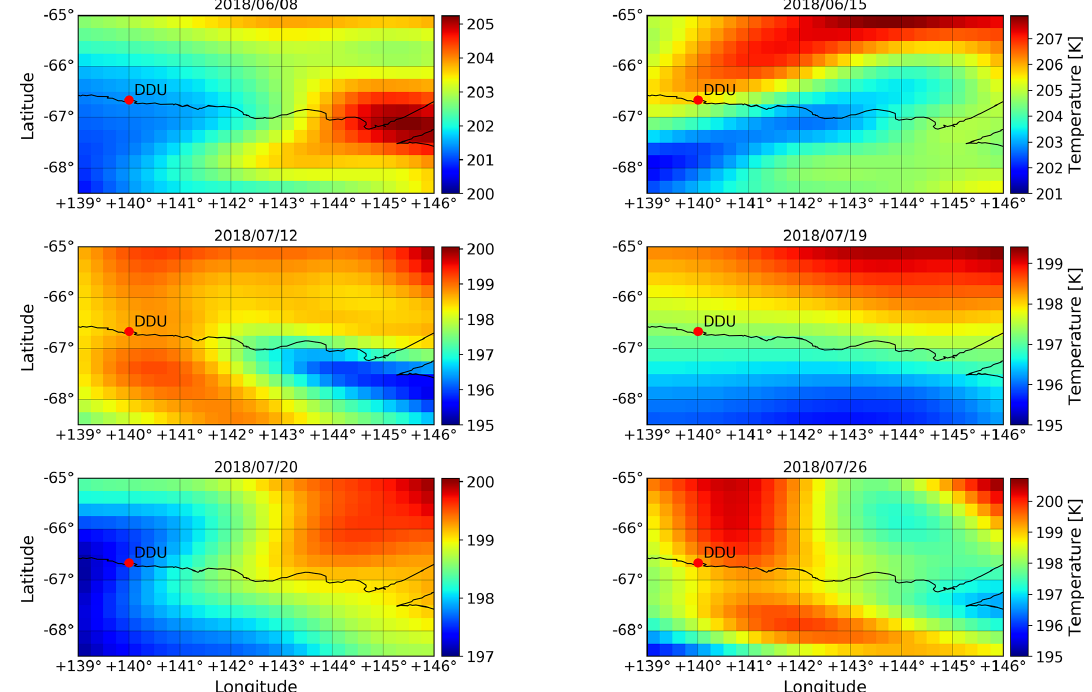
Figure A3. ERA5 reanalyses temperature fields at 100hPa for the domain corresponding to the radiosondes drift shown in Fig. 8.